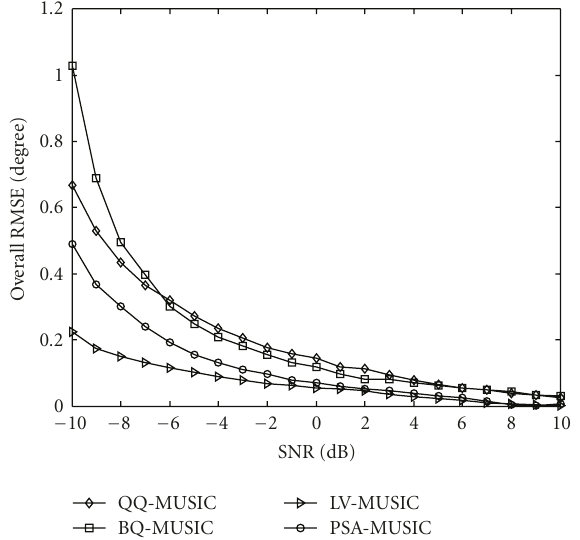
Figure 9: RMS estimation errors versus SNR in the presence of sensor orientation